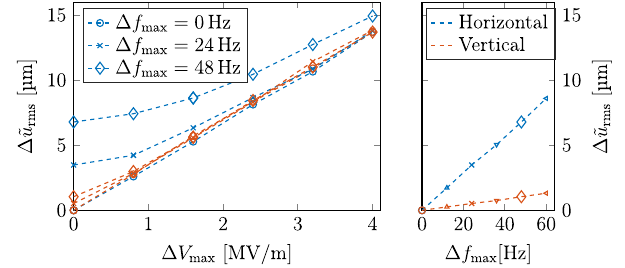
FIG. 16. Normalized rms intrabunch-train trajectory variation Δ ˜ u downstream the European XFEL accelerator as a function rms of the maximum variation of the amplitude of the accelerating field Δ V (left) for the horizontal (blue) and vertical (red) max plane. The different plot marks correspond to different maximum detuning Δ f . The right plot shows the trajectory variation for max zero amplitude variation as a function of Δ f max